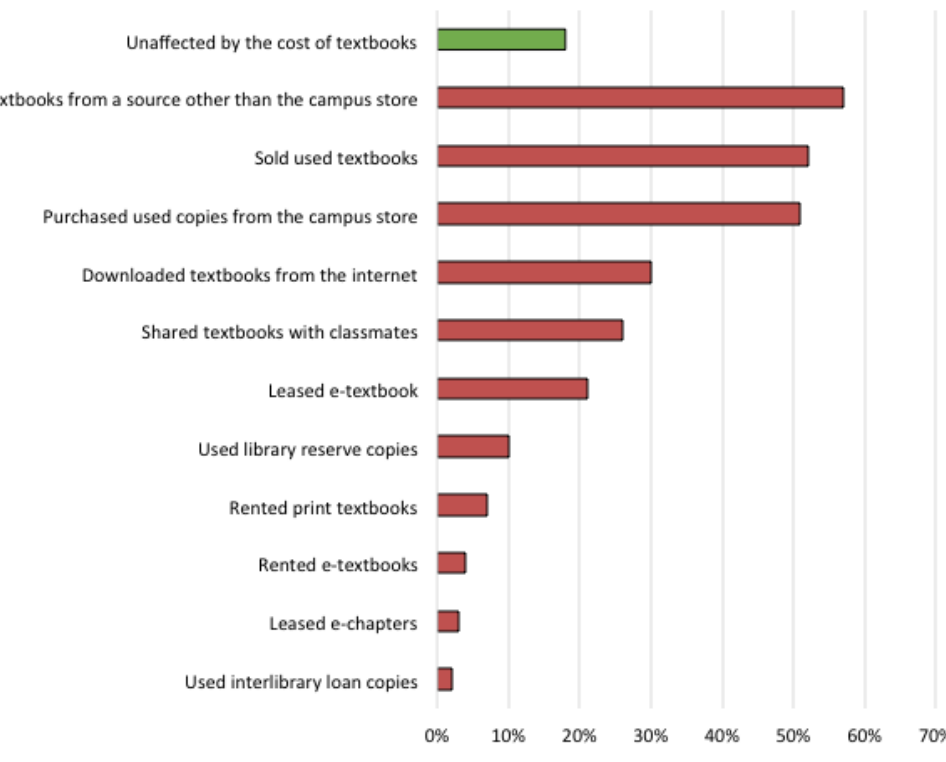
Figure 3. Impact of textbook costs on students’ textbook purchasing